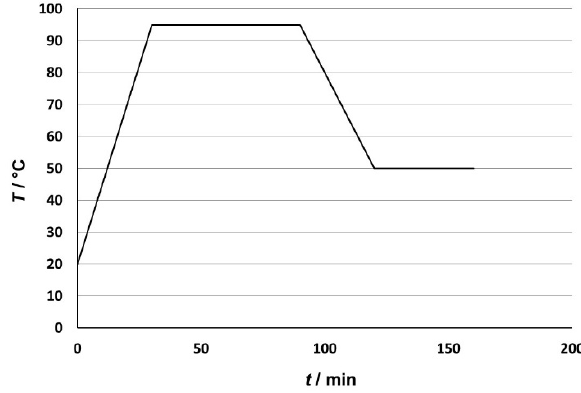
Figure 2. Schematic presentation of the dyeing